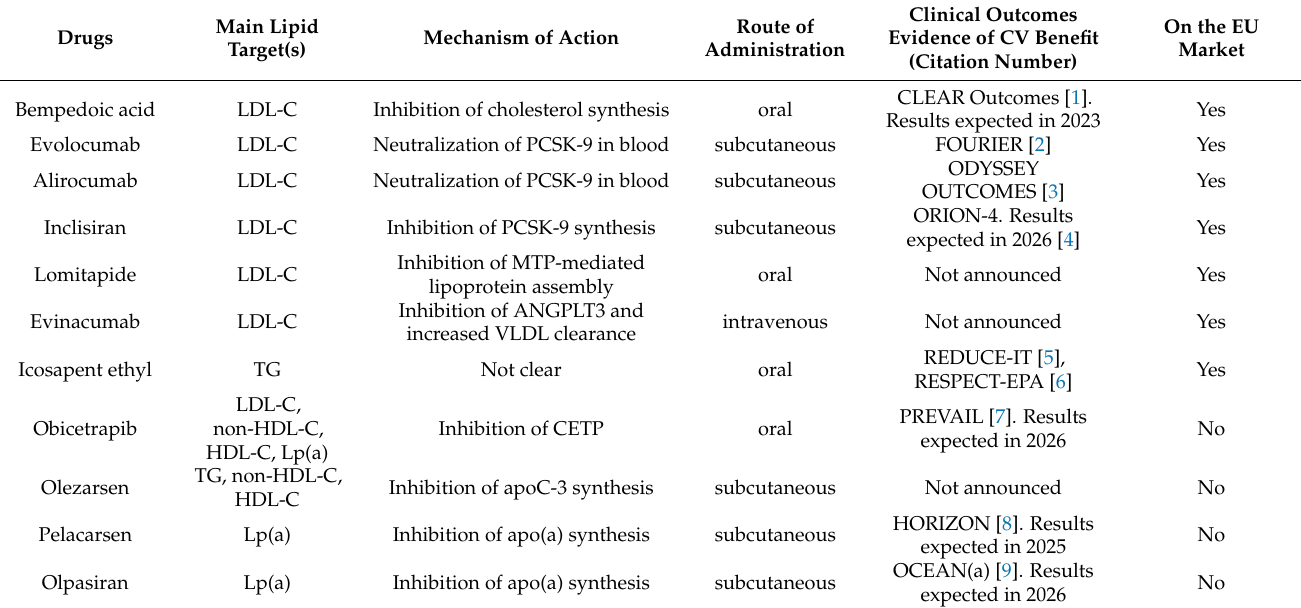
Table 1. Relevant features of the new lipid-lowering